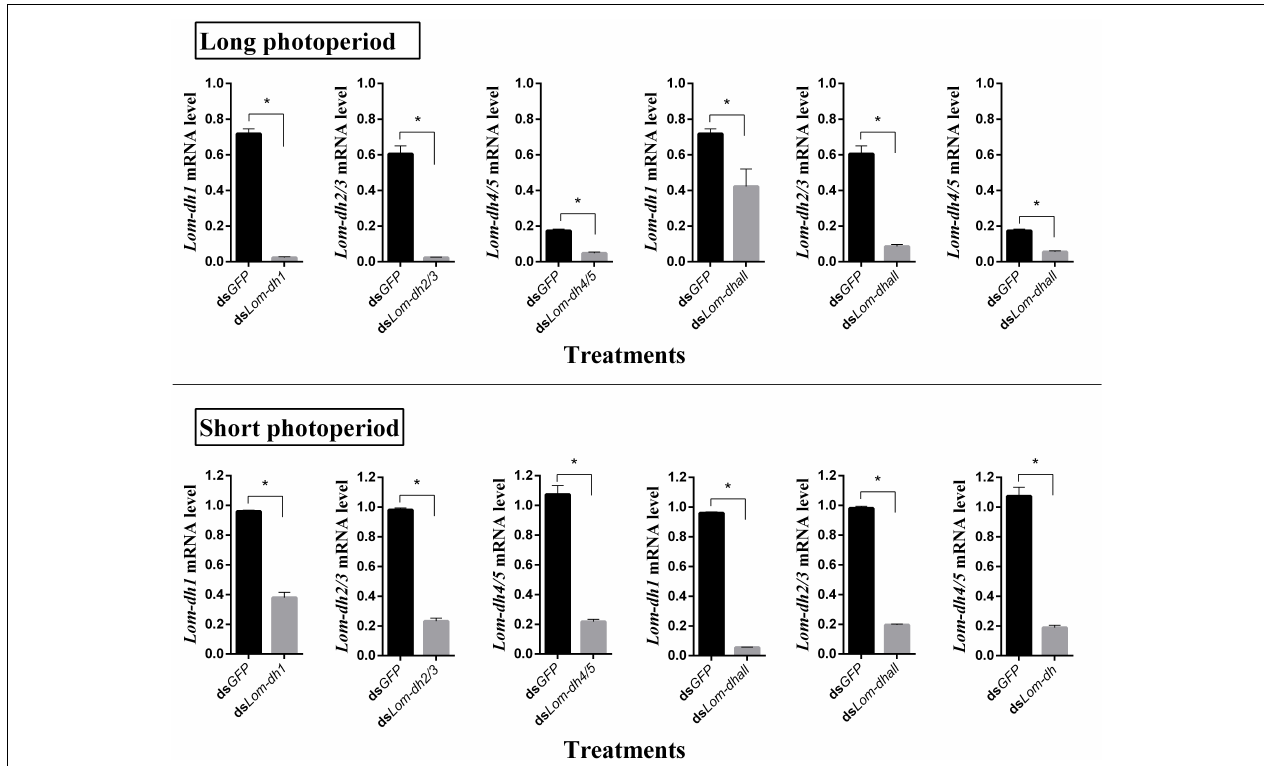
FIGURE 5 | RNAi efficiency of Lom-dh genes detect in L. migratoria under long and short photoperiod. ∗ Indicates an error probability of p < 0.05 by Student’s t -test.